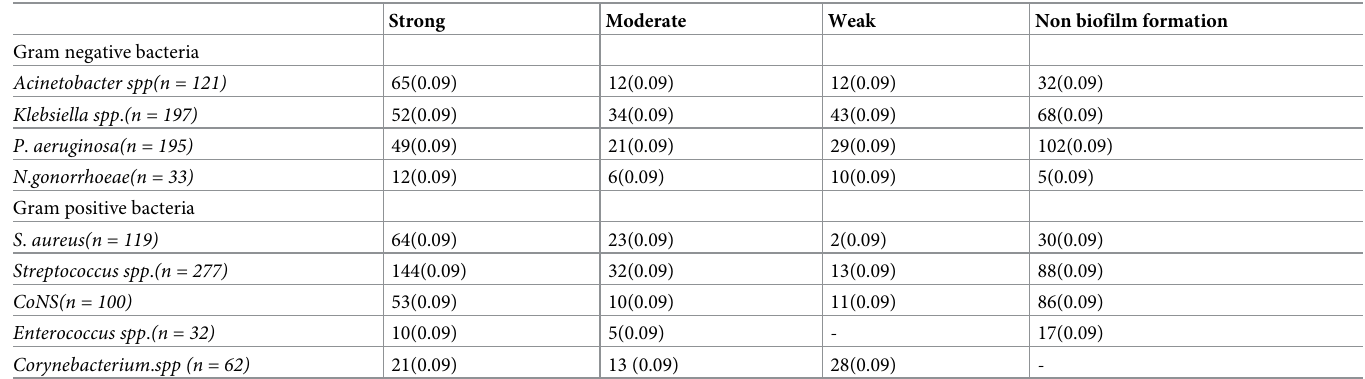
Table 5. Biofilm formation of Gram-positive bacteria and Gram negative